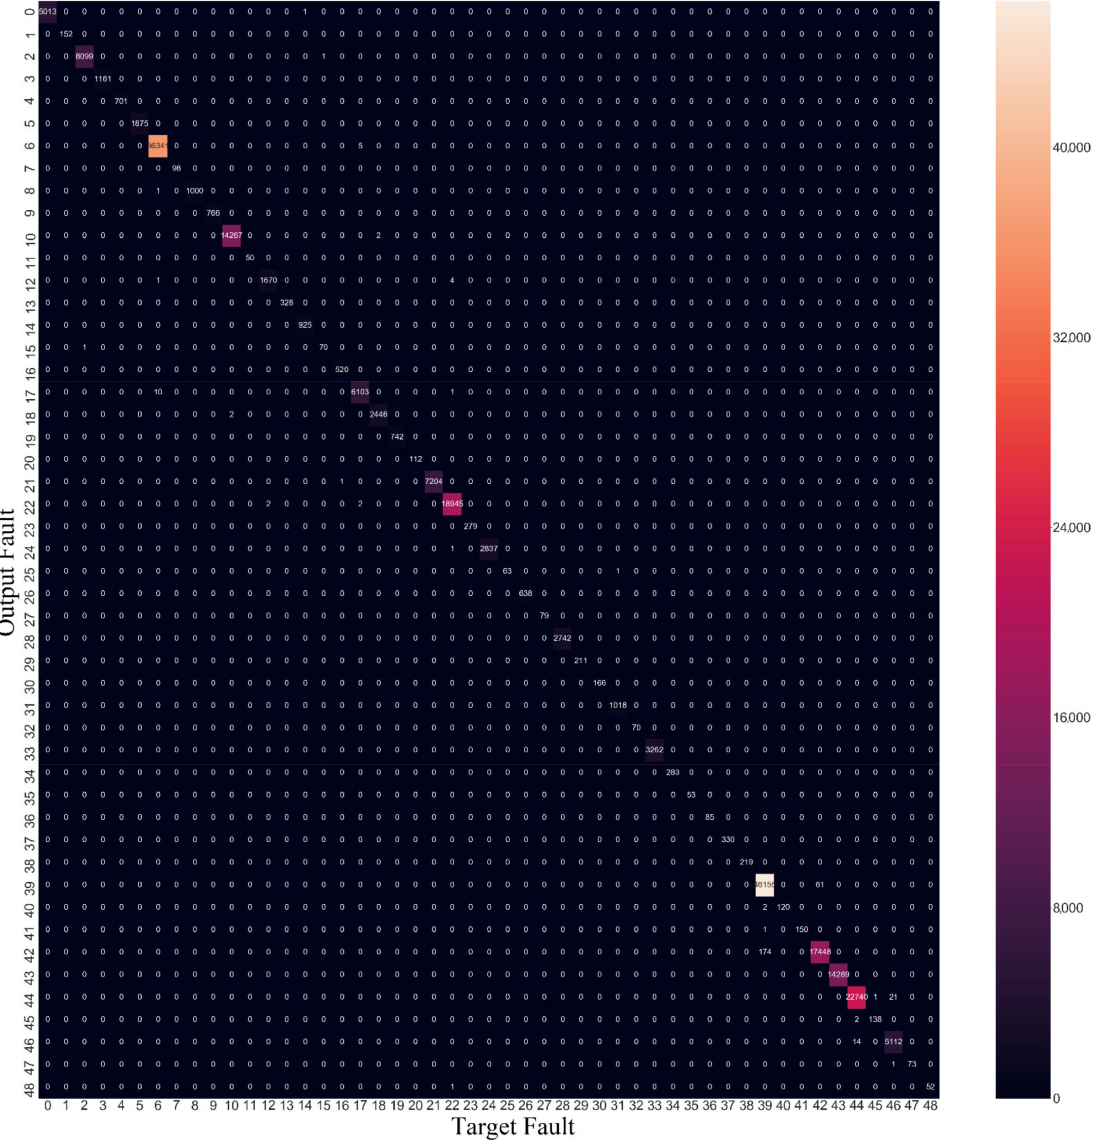
Figure 8. Confusion matrix of